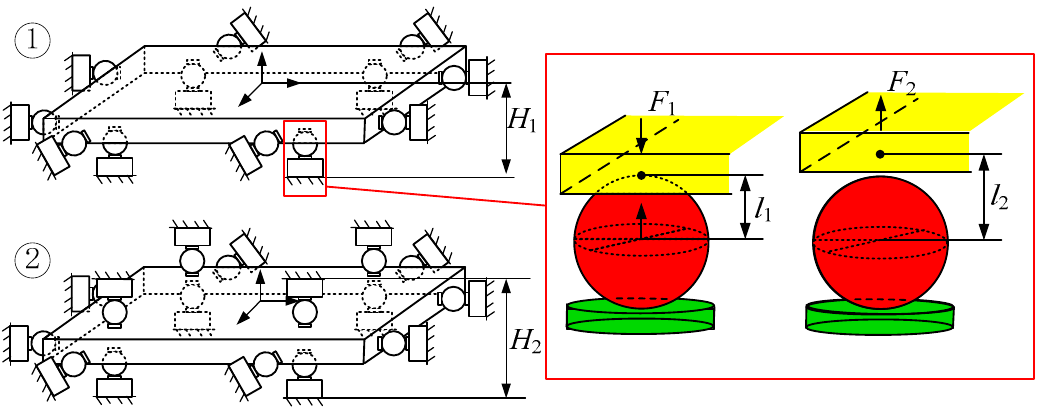
Figure 1. Schematic of a steel ball structure multi-dimensional force sensor.